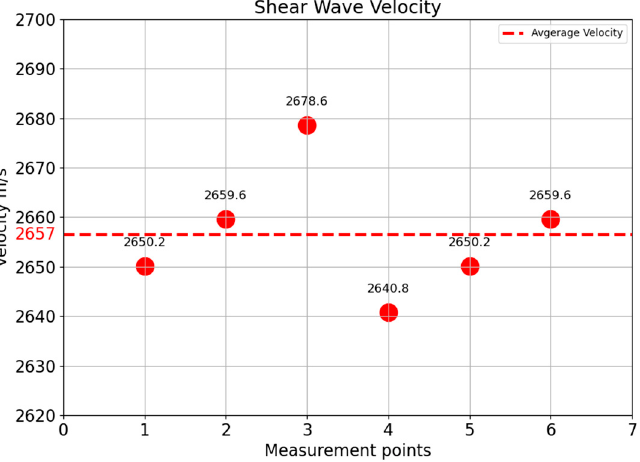
Figure 18. Shear wave velocity of different points on half cylindrical test specimen.